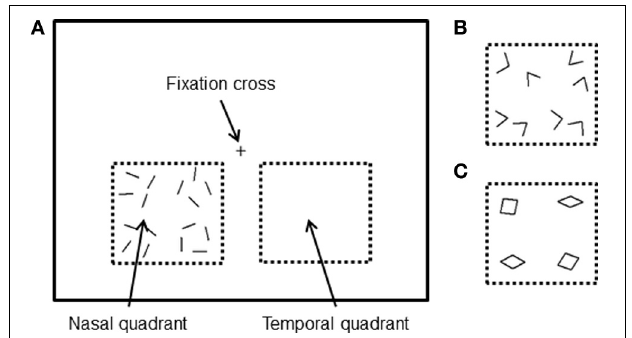
FIGURE 1 | Stimuli were viewed using the right eye only and were presented in the lower region of the visual field in either the nasal or temporal quadrant. All stimuli consisted of 16 white lines, presented either separately (A) , joined to form eight angles (B) or joined to form four rhombuses (C)